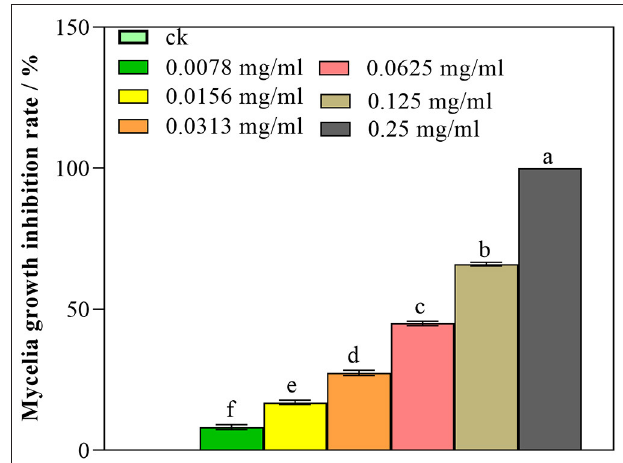
FIGURE 1 | Antifungal activity of nanoemulsions against P. digitatum. Values are the mean ± standard deviation (SD) of three replicates. Different letters above the bars on columns indicate a significant difference ( P < 0.05).